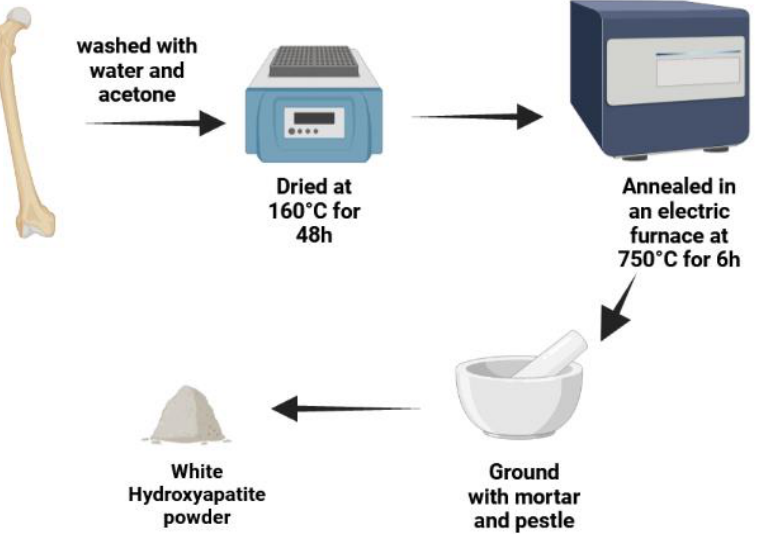
Figure 1. Schematic diagram illustrates the preparation steps of nanohydroxyapatite from natural bovine bone. Created with BioRender.com. bovine bone. Created with